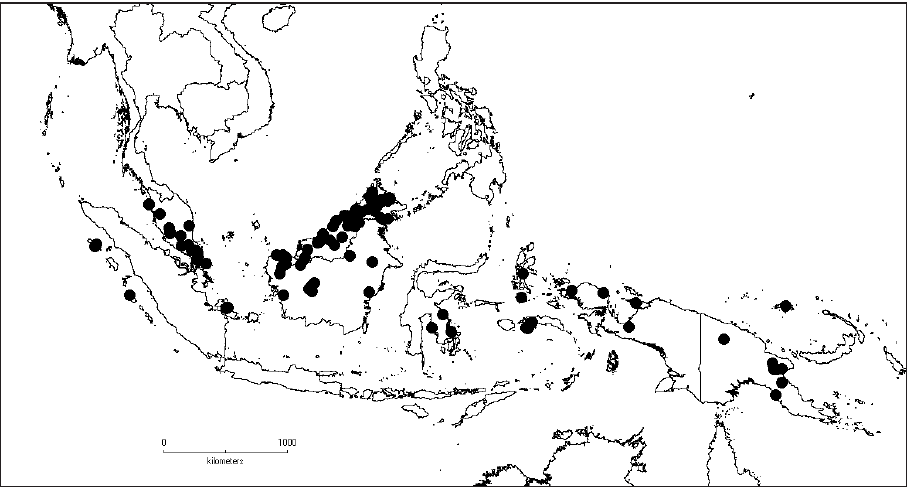
Map 3. Distribution of D. annulata ( ●